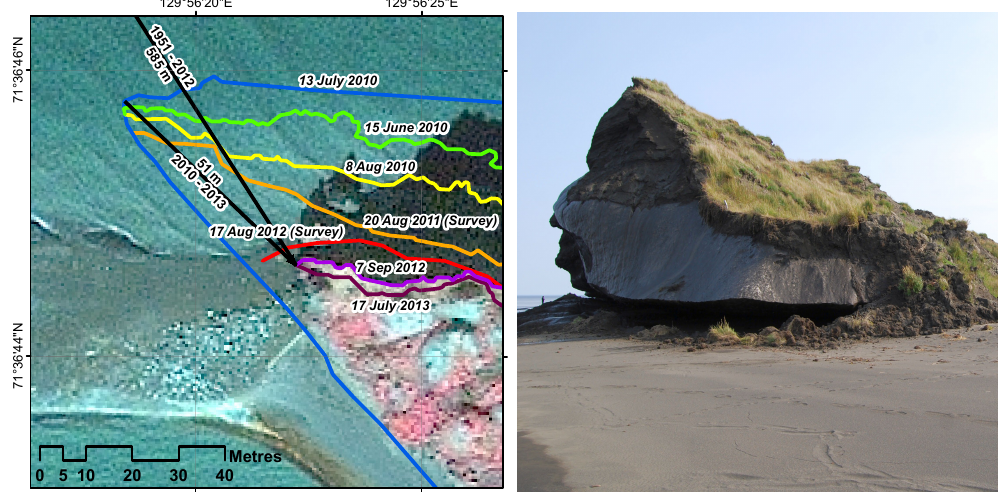
Figure 14. Close up view of coastal erosion at the northern cape of Muostakh Island. Left: selected cliff top position lines of the 2010–2013 period. Blue line outlines cliff bottom position in early 2010. Ends of cliff top lines are at sea level, marking the northernmost point of the island. Note stranded ground ice debris on the sand spit. Right: photograph of the northern cape (8 August 2012).